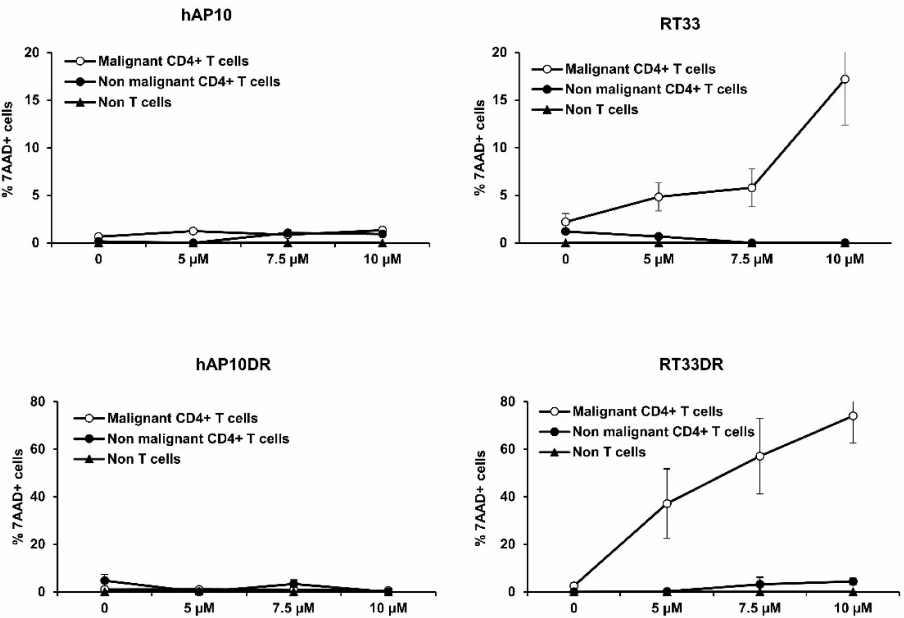
Figure 7. RT33 and RT33DR specifically induce primary S é zary cells death. S é zary patients’ PBMC were incubated with increasing concentrations of the indicated peptides for 4h at 37 ◦ C. Cells were then analyzed by flow cytometry following labeling with anti-TCRV β -FITC, − CD4 − PE, − CD3 − PE − Cy7 mAbs and 7-AAD. Data are shown as the means ± s.e.m. of the percentage of 7-AAD + apoptotic cells within the following populations: malignant (CD3 + CD4 + TCR-V β + ) and non-malignant (CD3 + CD4 + TCR-V β − ) CD4 + T-cells and non T-cells (CD3 − ), derived from three di ff erent